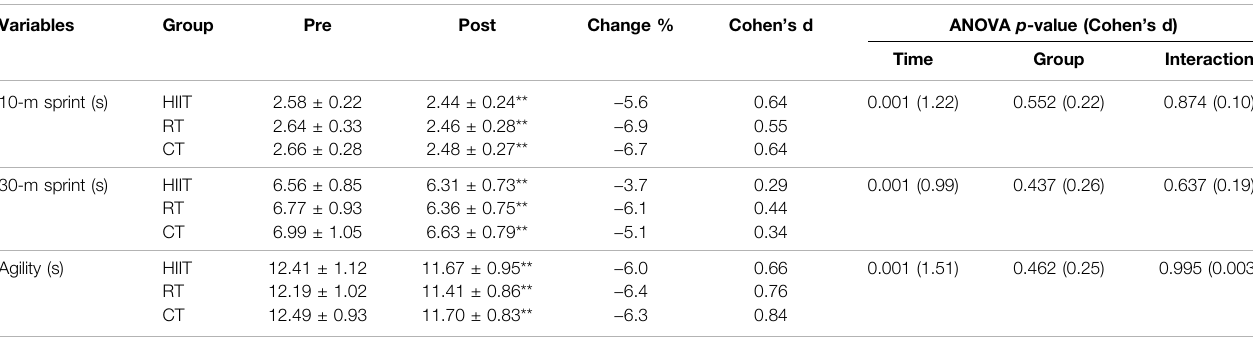
TABLE 5 | Effects of 9 weeks of training on sprint and agility tests (mean ± SD).